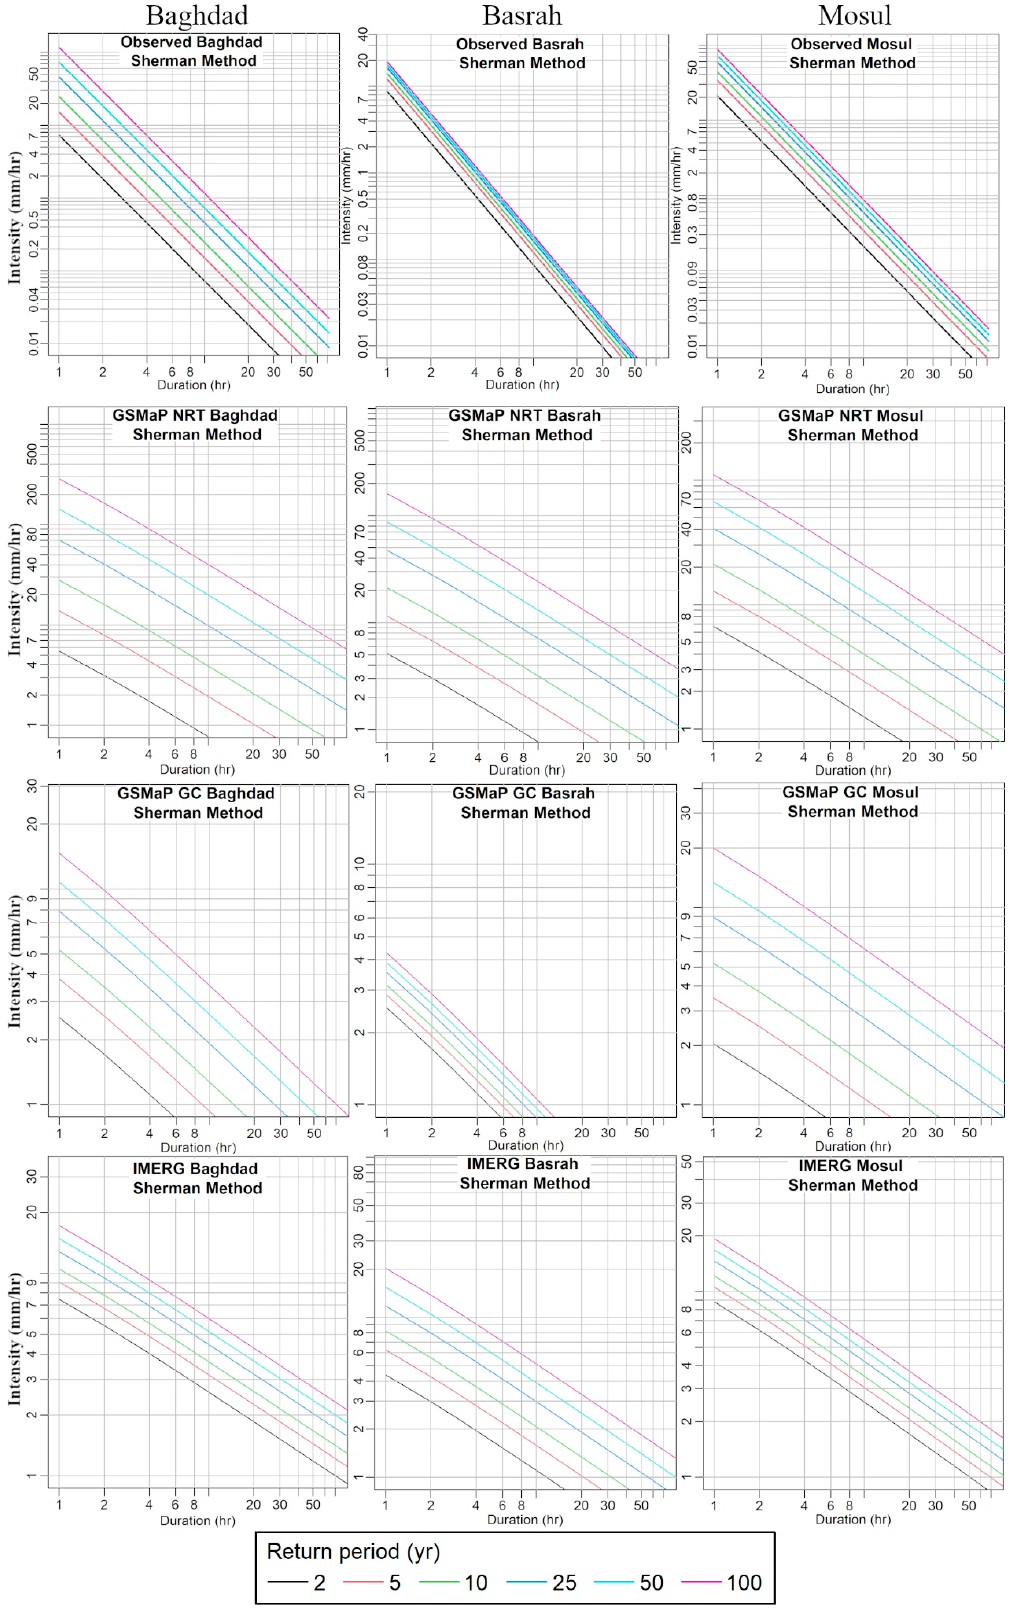
Figure 9. IDF curves at three Iraqi cities using satellite (GSMaP NRT, GSMaP GC, and IMERG) and observed rainfall data from 2000 to 2022 based on the Sherman method.